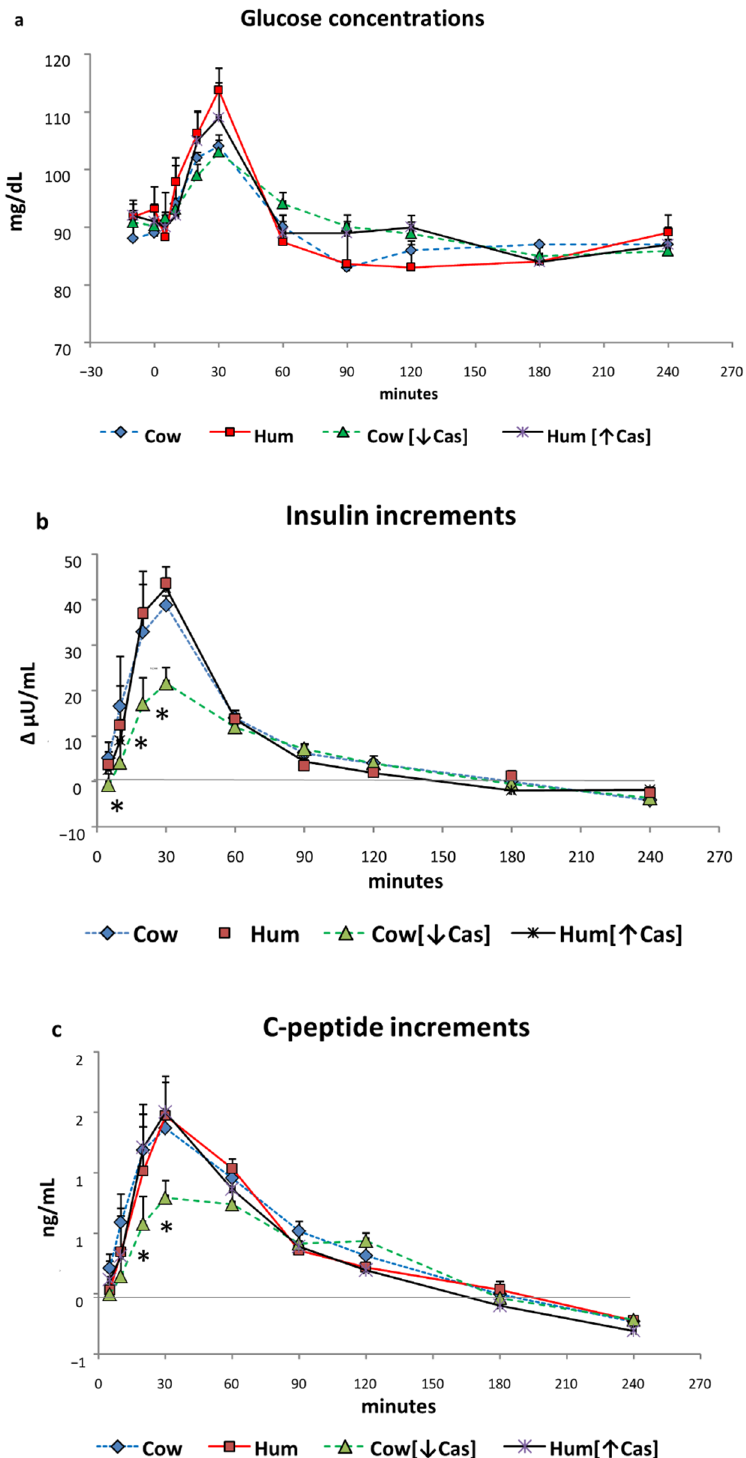
Figure 2. Glucose, insulin, and C-peptide. Abbreviations: Hum: human; Cow [ ↓ Cas]: low-casein cow milk; Hum [ ↑ Cas]: high-casein human milk; WP: whey protein. ( a ): Plasma glucose concentrations (expressed as mg/dL) before and following milk administration over the 240 min study period. Data are mean ± SEM. No significant differences between the four milk types were detected at any time points. Sample size: Cow, n = 7; Hum, n = 8; Cow [ ↓ Cas], n = 10; and Hum [ ↑ Cas], n = 7. ( b ): Increments vs. basal values of plasma insulin concentrations (expressed as Δ μU/mL) following milk admin- istration over the 240 min study period. Data are reported as mean ± SEM. The symbol (*) indicates